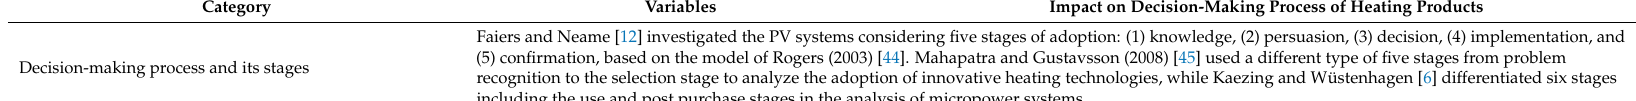
Table 1. Identified influencing factors with the adoption of diverse energy efficient technologies including heating products: PV: